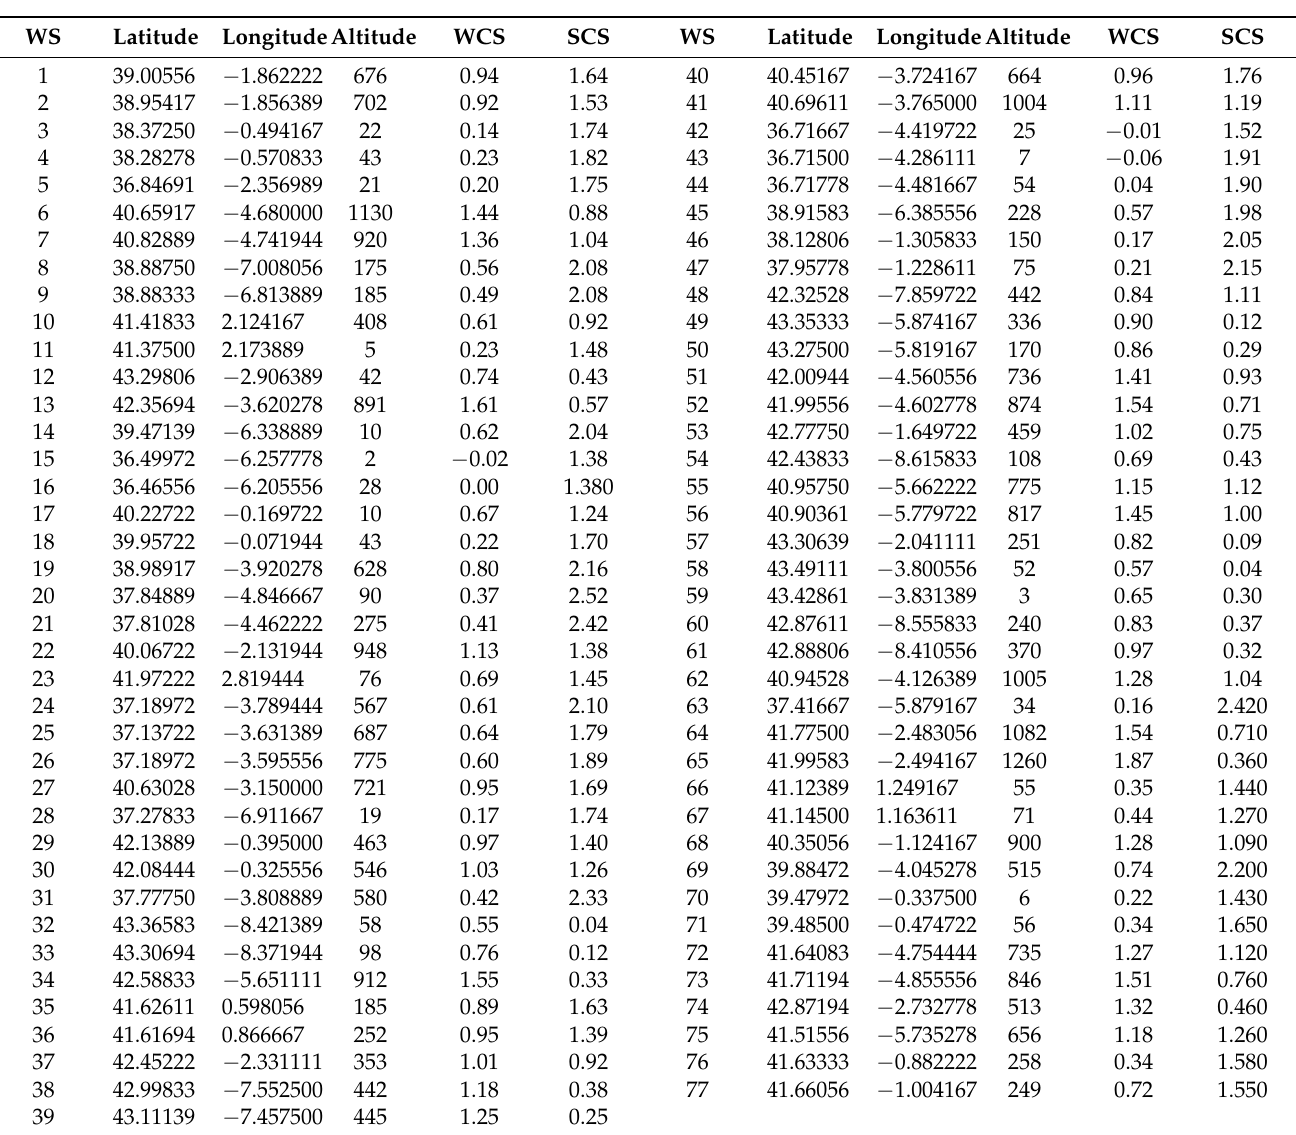
Figure 1. Geographical location of AEMET weather stations. Table 2. Calculated indices of winter (WCS) and summer (SCS) climate severity for the period 2015–2018. WS